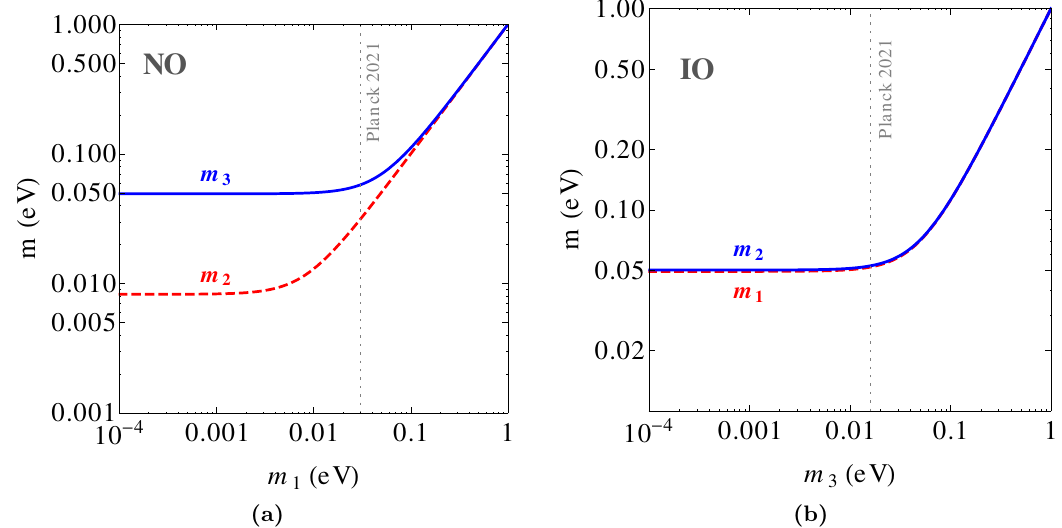
Figure 1. Neutrino mass patterns consistent with the results of the global fit, eqs. (2.1)–(2.3), for the case of (a) normal ordering (NO) and (b) inverted ordering (IO). The 95% C.L. upper bound by Planck, eq. (2.4), is shown as a gray dashed vertical